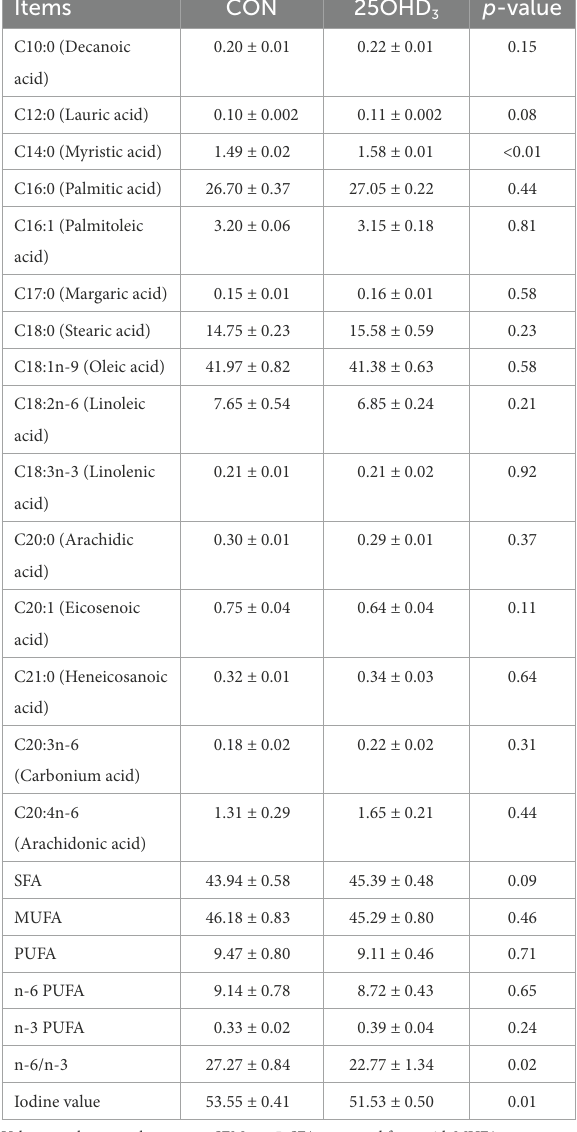
TABLE 6 Effects of 25OHD 3 supplementation on the fatty acid profile of longissimus dorsi (g/100 g total fatty acid). Items